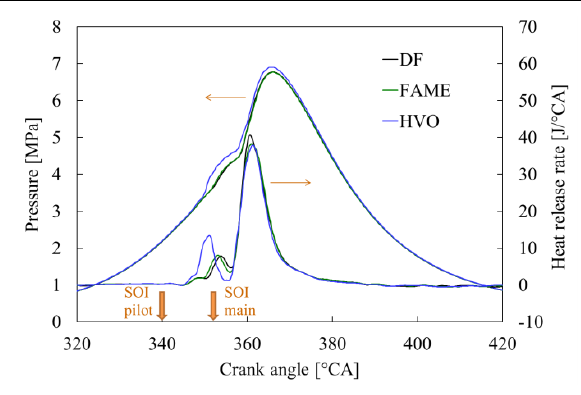
Fig. 2. In-cylinder pressures and HRRs for investigated fuels at 80 MPa rail pressure